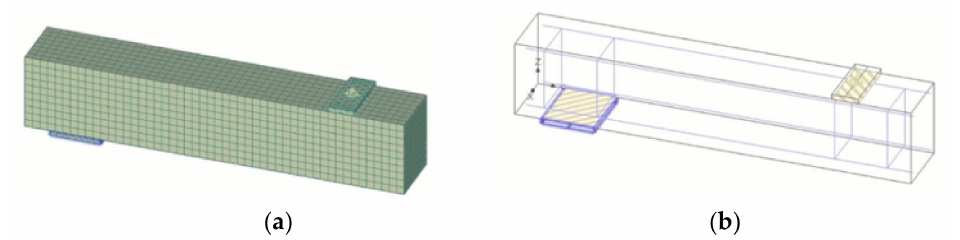
Figure 18. Typical FEM of RC beams using ATENA ( a ) geometry and ( b ) steel bars.